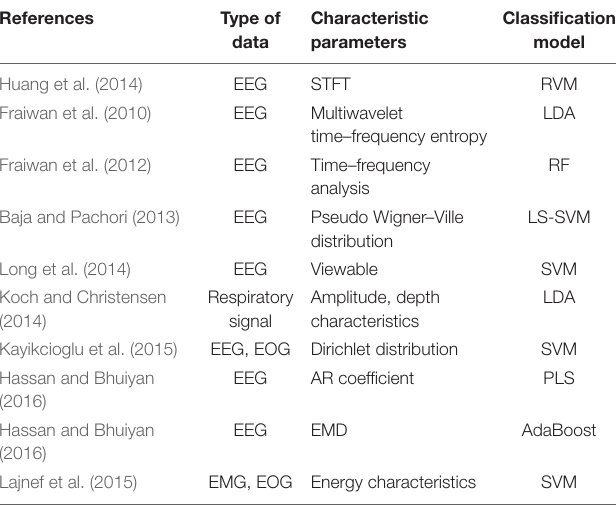
TABLE 1 | Research progress in sleep